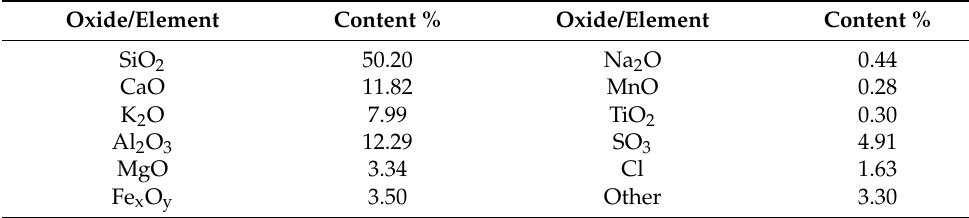
Table 1. Percentage of oxides and elements in fly